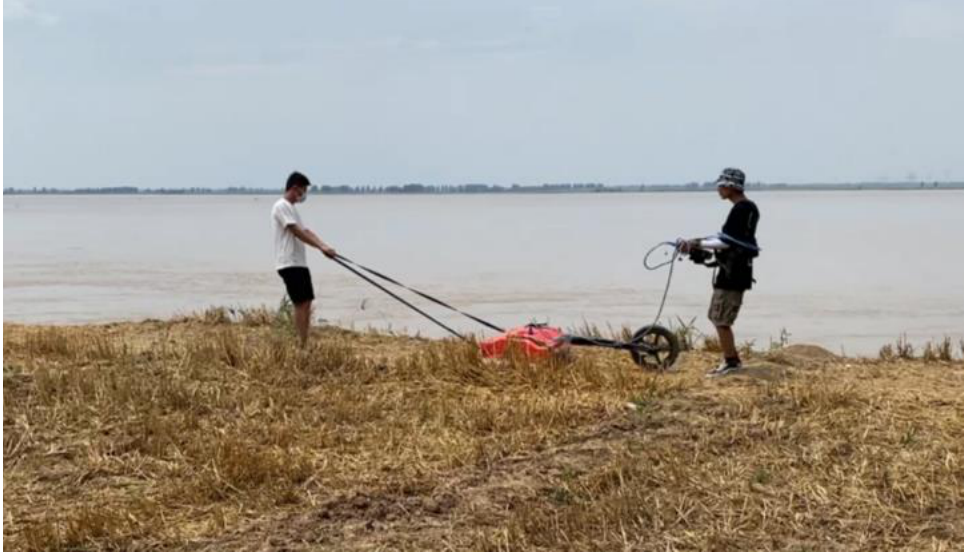
Figure A1. Scanning the floodplain in Wantan Town using the geological radar. Table A1. Soil sampling point locations.